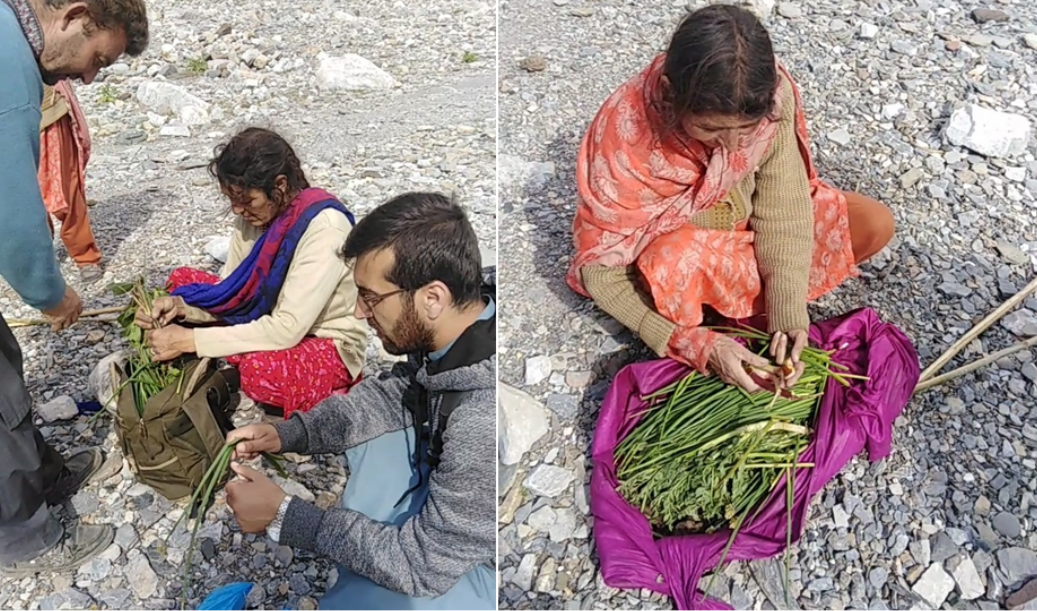
Figure 5. Locals and the first author after having gathered wild food plants in Nalla